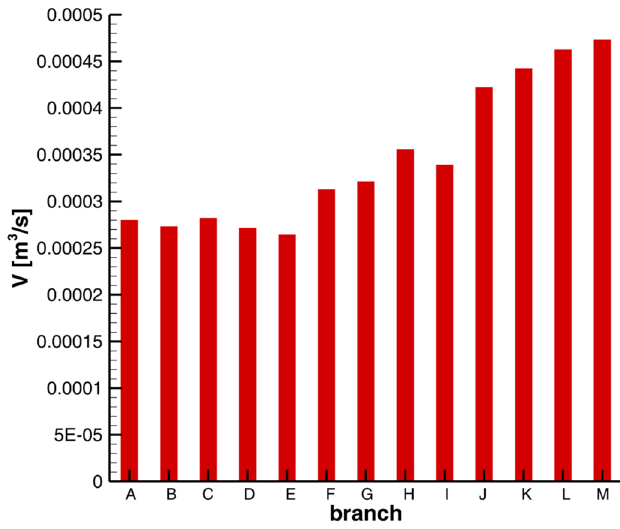
Fig. 2. Branches fl ow-rates.